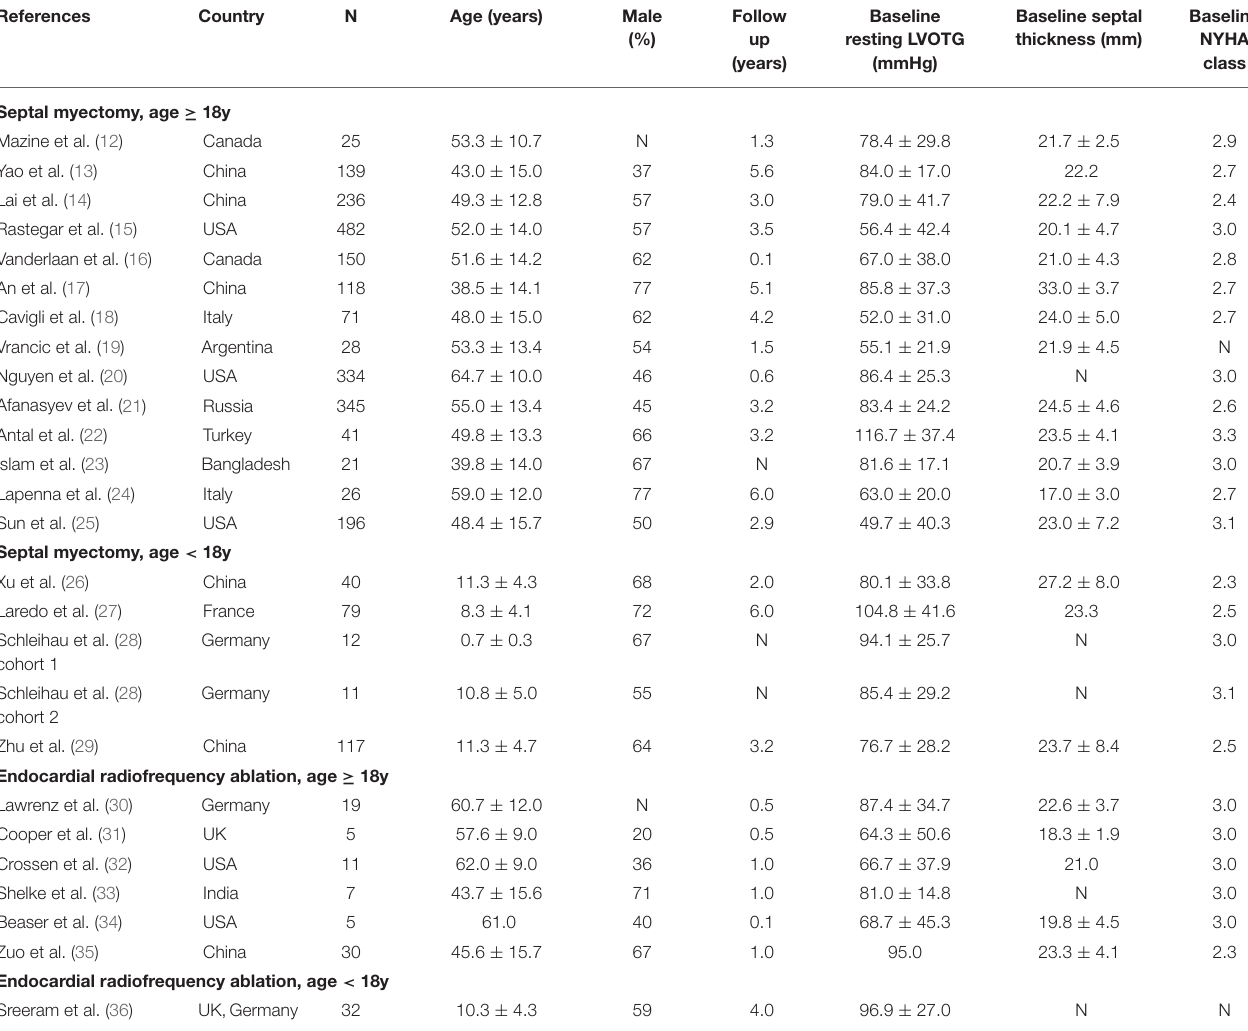
TABLE 1 | Baseline characteristics of the studies included in the